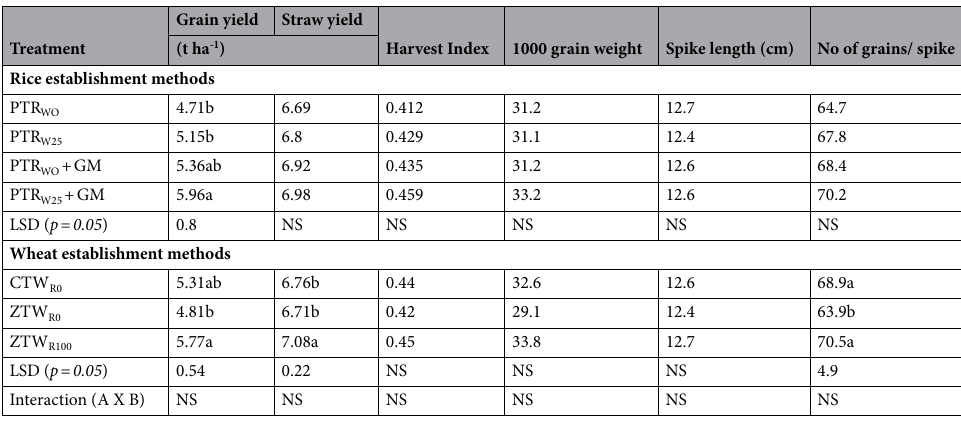
Table 2. Effect of tillage, green manure and residue management practices on yield and yield attributes of wheat. LSD Least significant difference, NS Non-significant. PTR W0 Puddled transplanted rice with no wheat straw, PTR W25 Puddled transplanted rice with 25% anchored wheat straw retained, GM Green manure, CTW R0 Conventional tillage wheat with rice straw removed, ZTW R0 Zero tillage wheat with rice straw removed, ZTW R100 ZTW with rice straw retained as surface mulch.